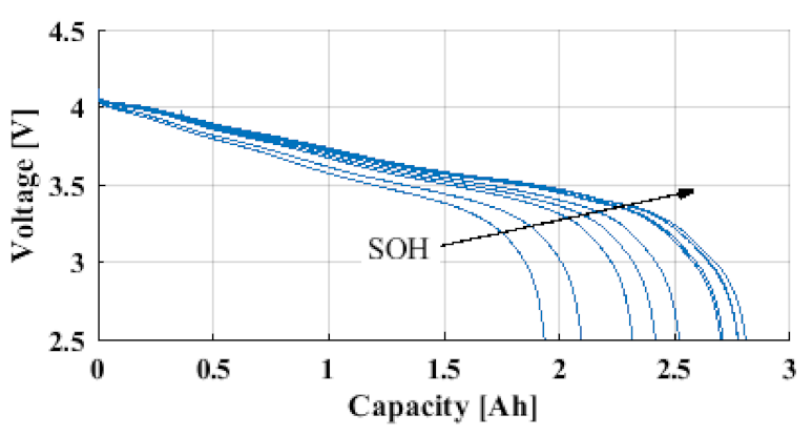
Figure 5. Characterization of the SOH based on cell voltage and capacity at ambient